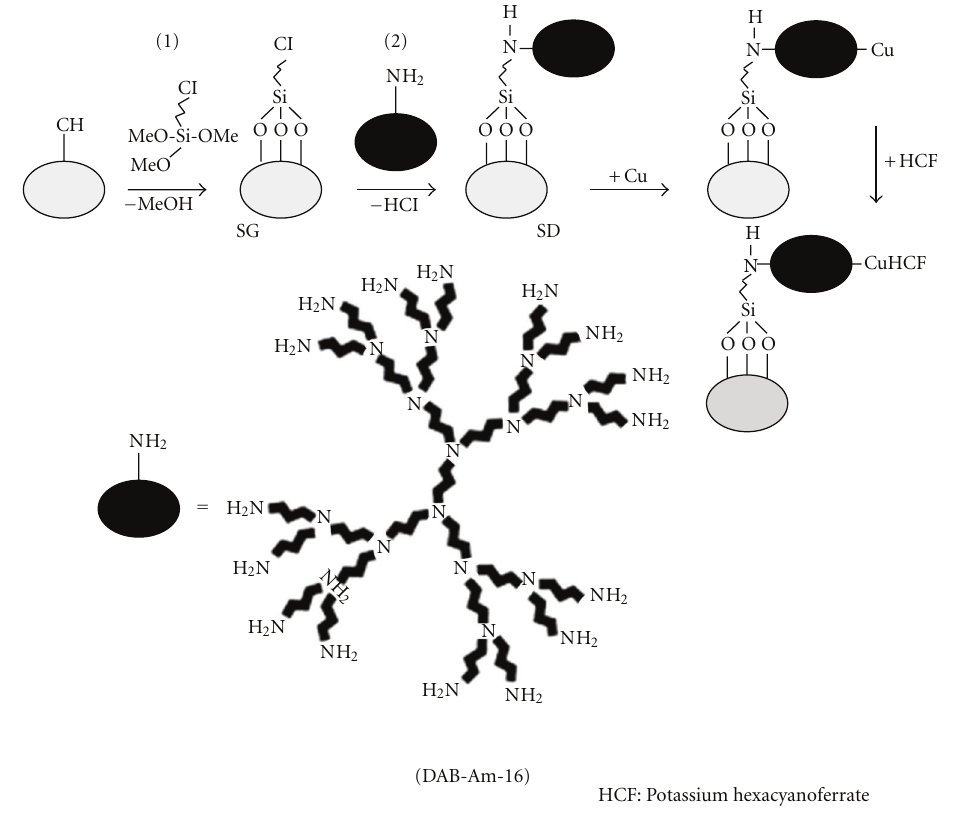
Figure 1: Schematic representation of the stages in the modification process of CuNPSD.